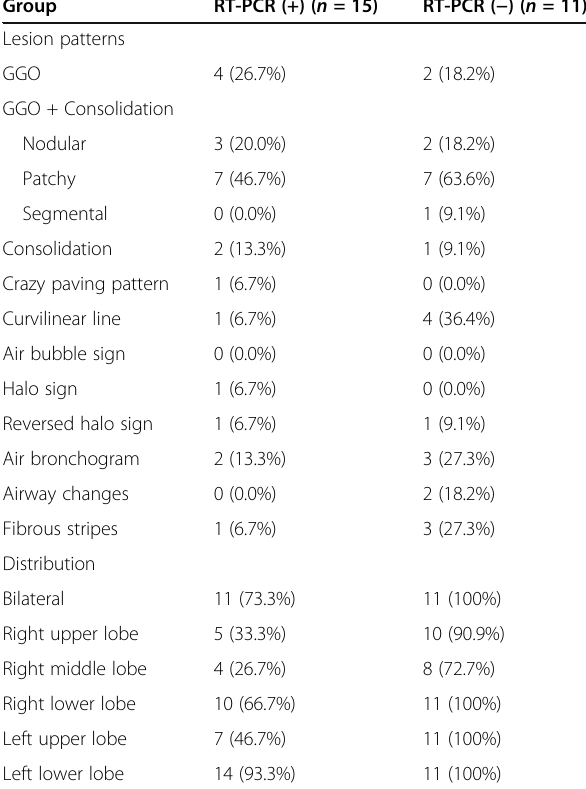
Table 2 CT imaging findings of asymptomatic patients (GGO; ground glass opacity, RT-PCR; reverse transcription polymerase